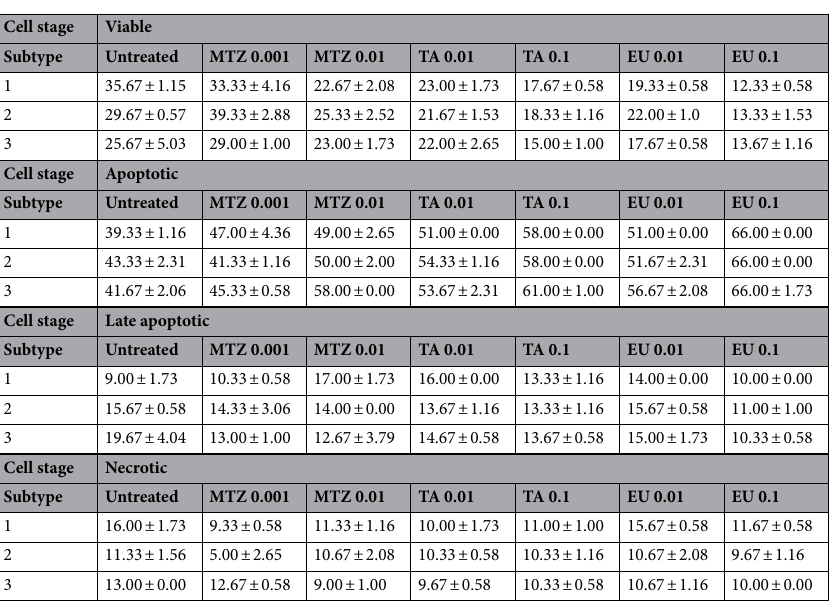
Table 1. Percentage of viable, apoptotic, late apoptotic stage and necrotic Blastocystis sp. cells after 72 h of culture. Data are expressed as the mean ±